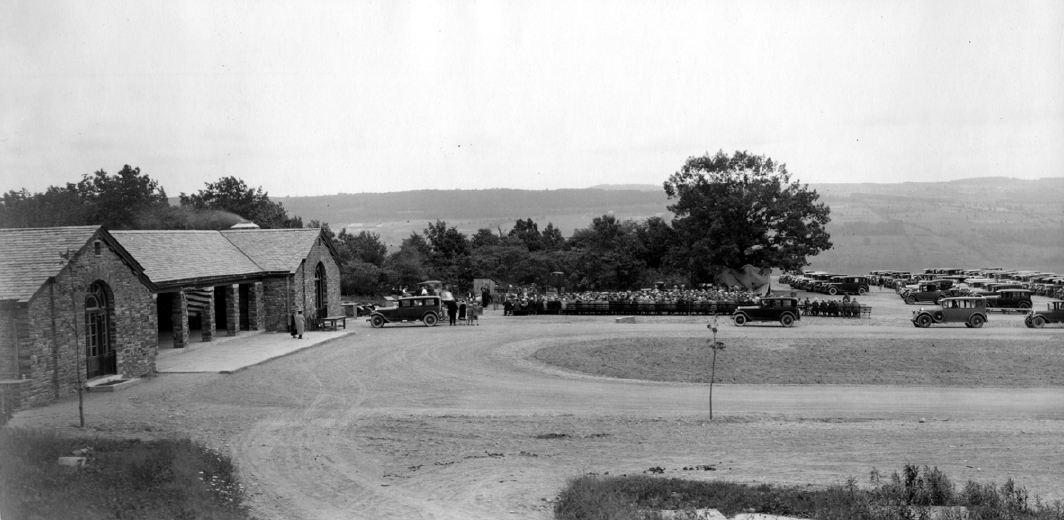
Figure 11. South Pavilion and South Entrance Parking Lot, ca. 1927. Photo used with permission: NY State Office of Parks, Recreation & Historic Preservation; parks.ny.gov (accessed on 12 June